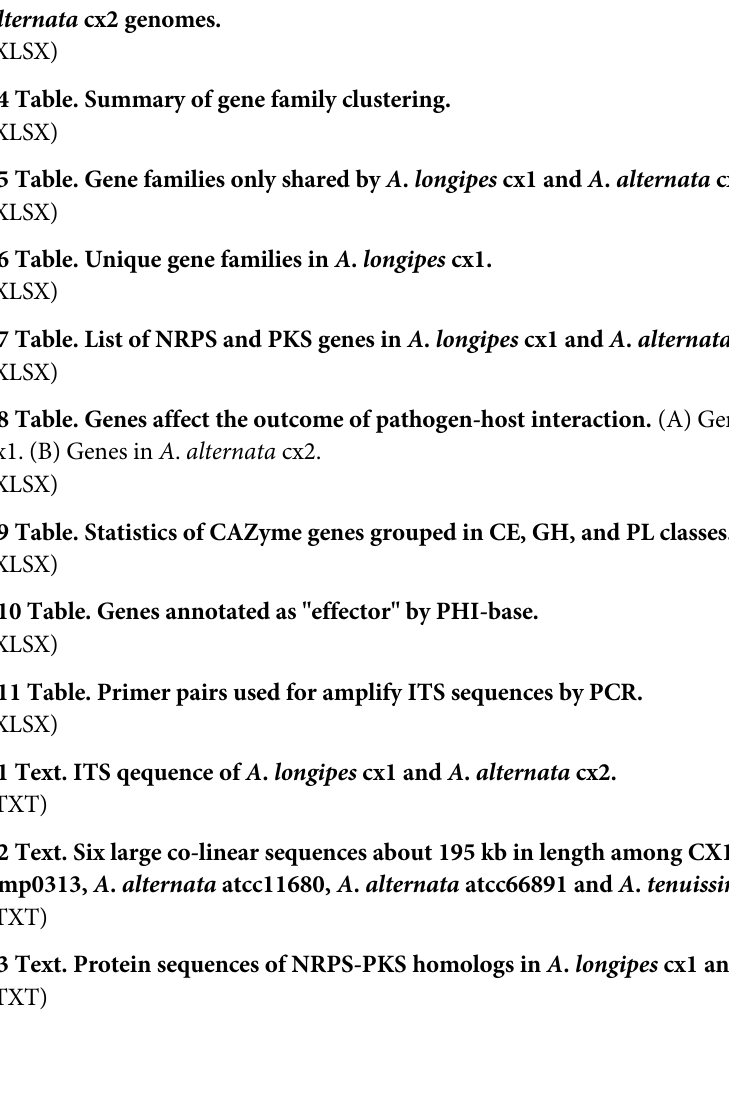
S2 Table. Number of genes in A . longipes cx1 and A . alternata cx2 with homologs or func- tional classification in different databases. S3 Table. Statistics of repeat sequences and transposable elements of A . longipes cx1 and A . alternata cx2 genomes. S4 Table. Summary of gene family clustering. S5 Table. Gene families only shared by A . longipes cx1 and A . alternata cx2. (XLSX) S6 Table. Unique gene families in A . longipes cx1. S7 Table. List of NRPS and PKS genes in A . longipes cx1 and A . alternata cx2. S8 Table. Genes affect the outcome of pathogen-host interaction. (A) Genes in A . longipes